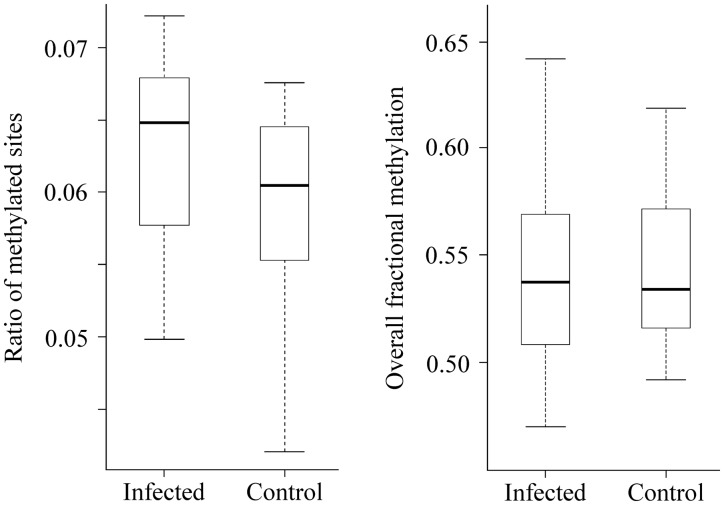
Parasite infection induces changes in DNA methylation levels. We represent the RMS. The overall fractional methylation is also given for each treatment group. Error bars represent ±1 SD.